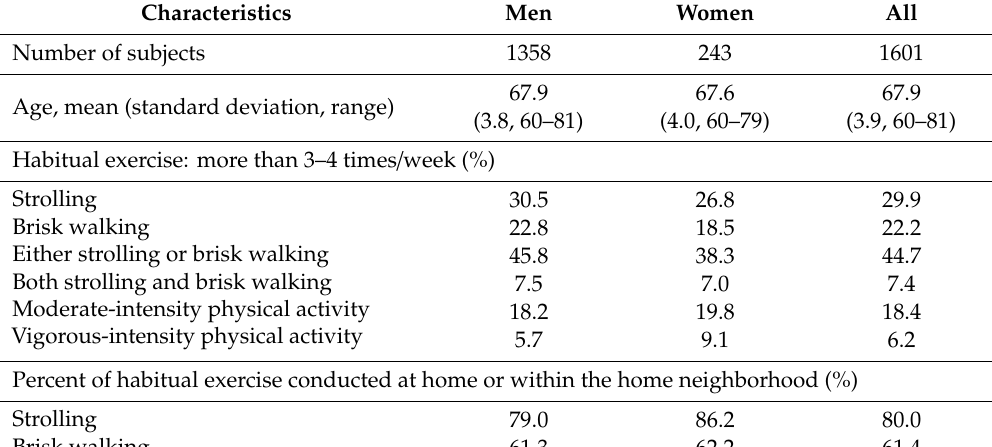
Table 1. Characteristics of retired civil servants, Aichi Workers Cohort, 2016. Characteristics